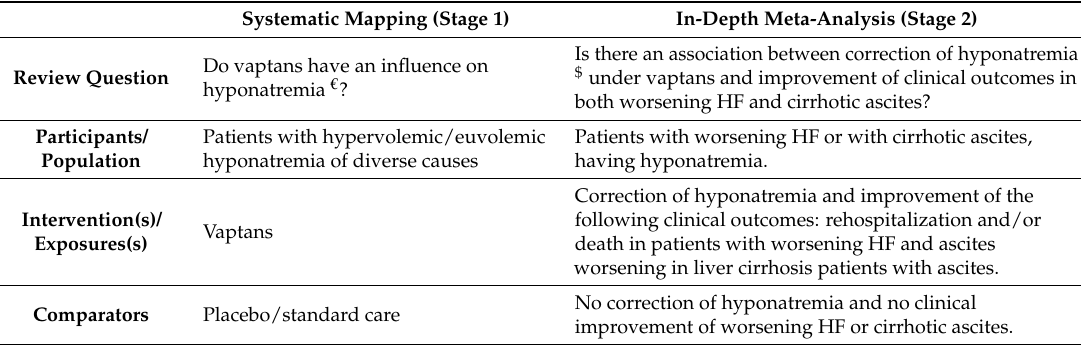
Table 1. Specific stage review questions and study